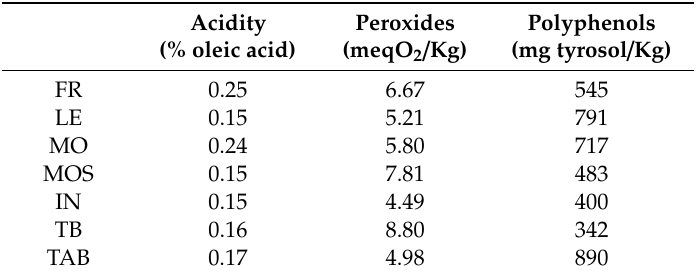
Table 2. Acidity, peroxides, and polyphenols of EVOOs samples